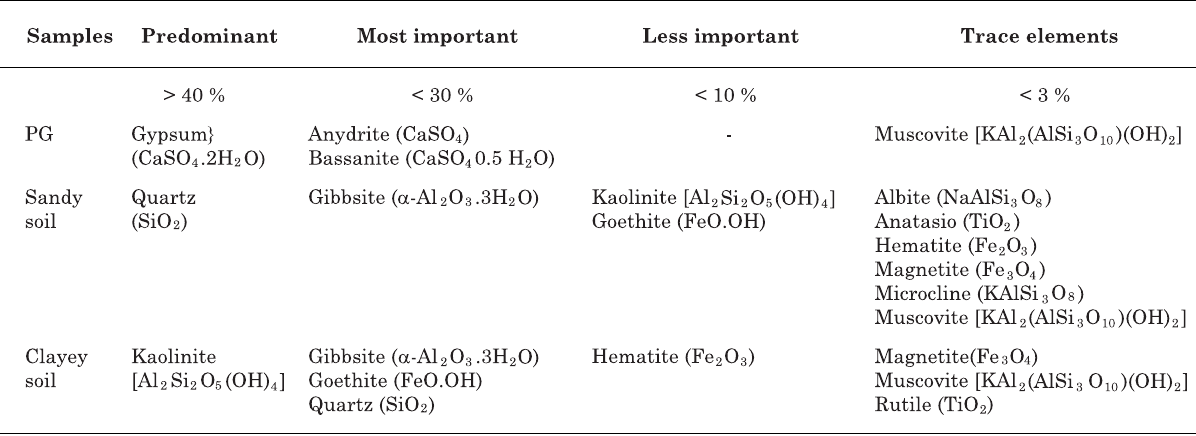
Table 2. Results of the mineralogical composition